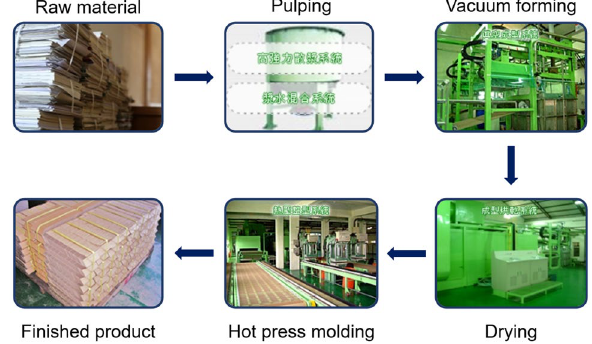
Figure 13. The production flow of Chang-Tai paper mold products.